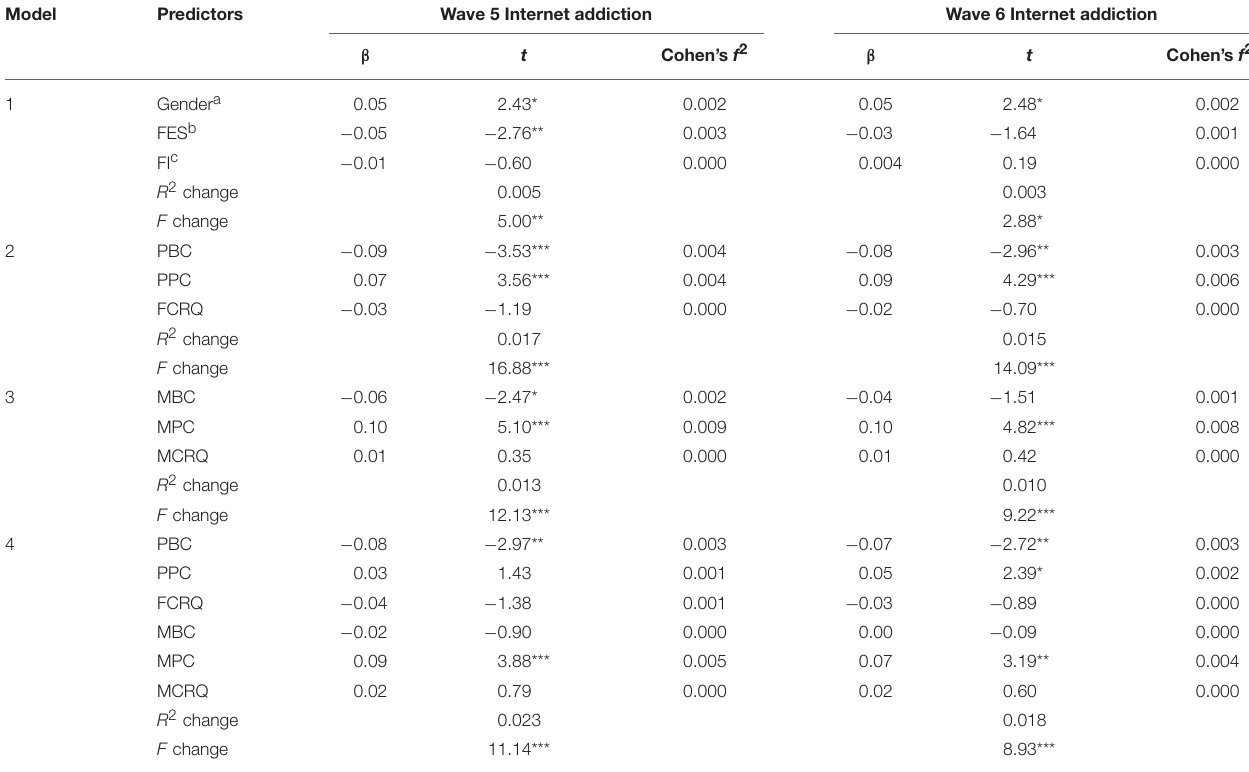
TABLE 8 | Longitudinal predicting effects of parent–child subsystem qualities on Internet addiction.